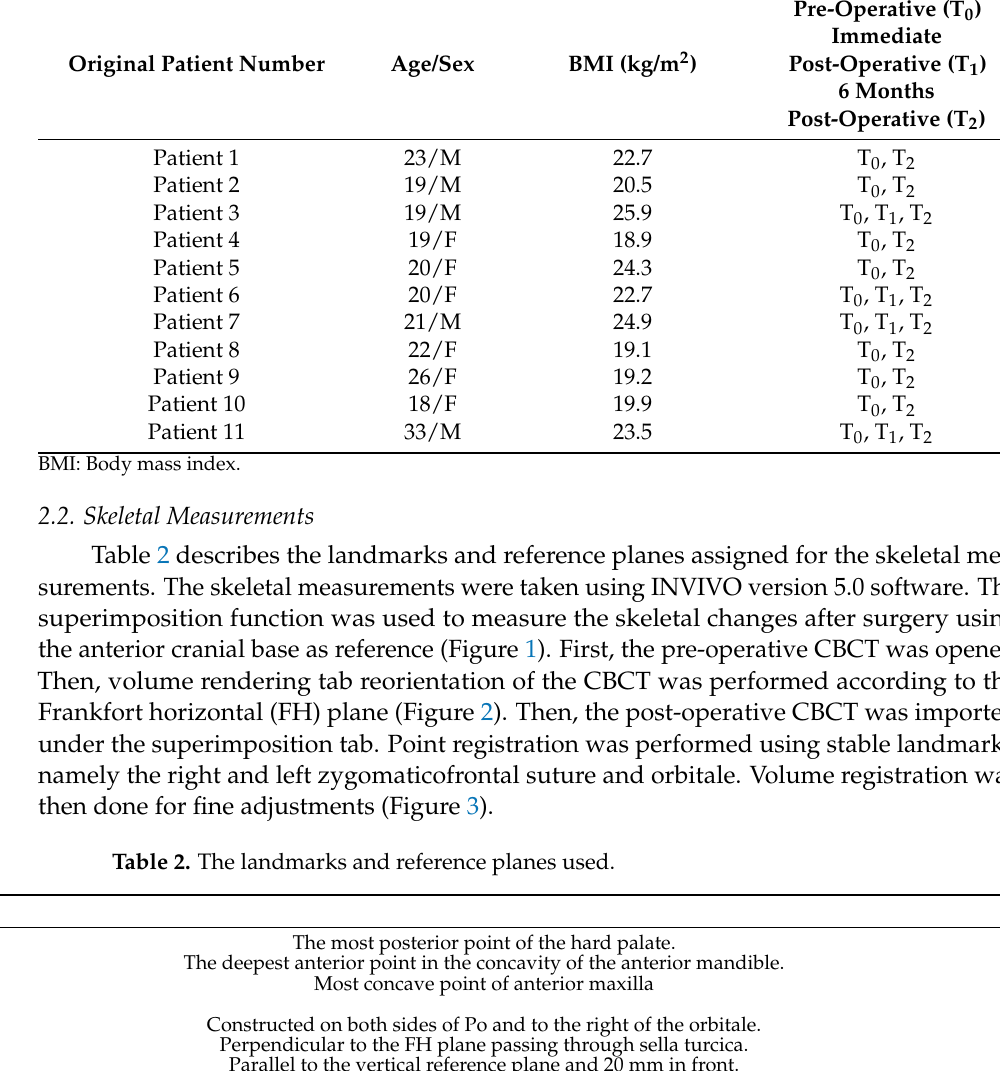
Table 1. Details of the patients included in the computational fluid dynamics (CFD) simulation.